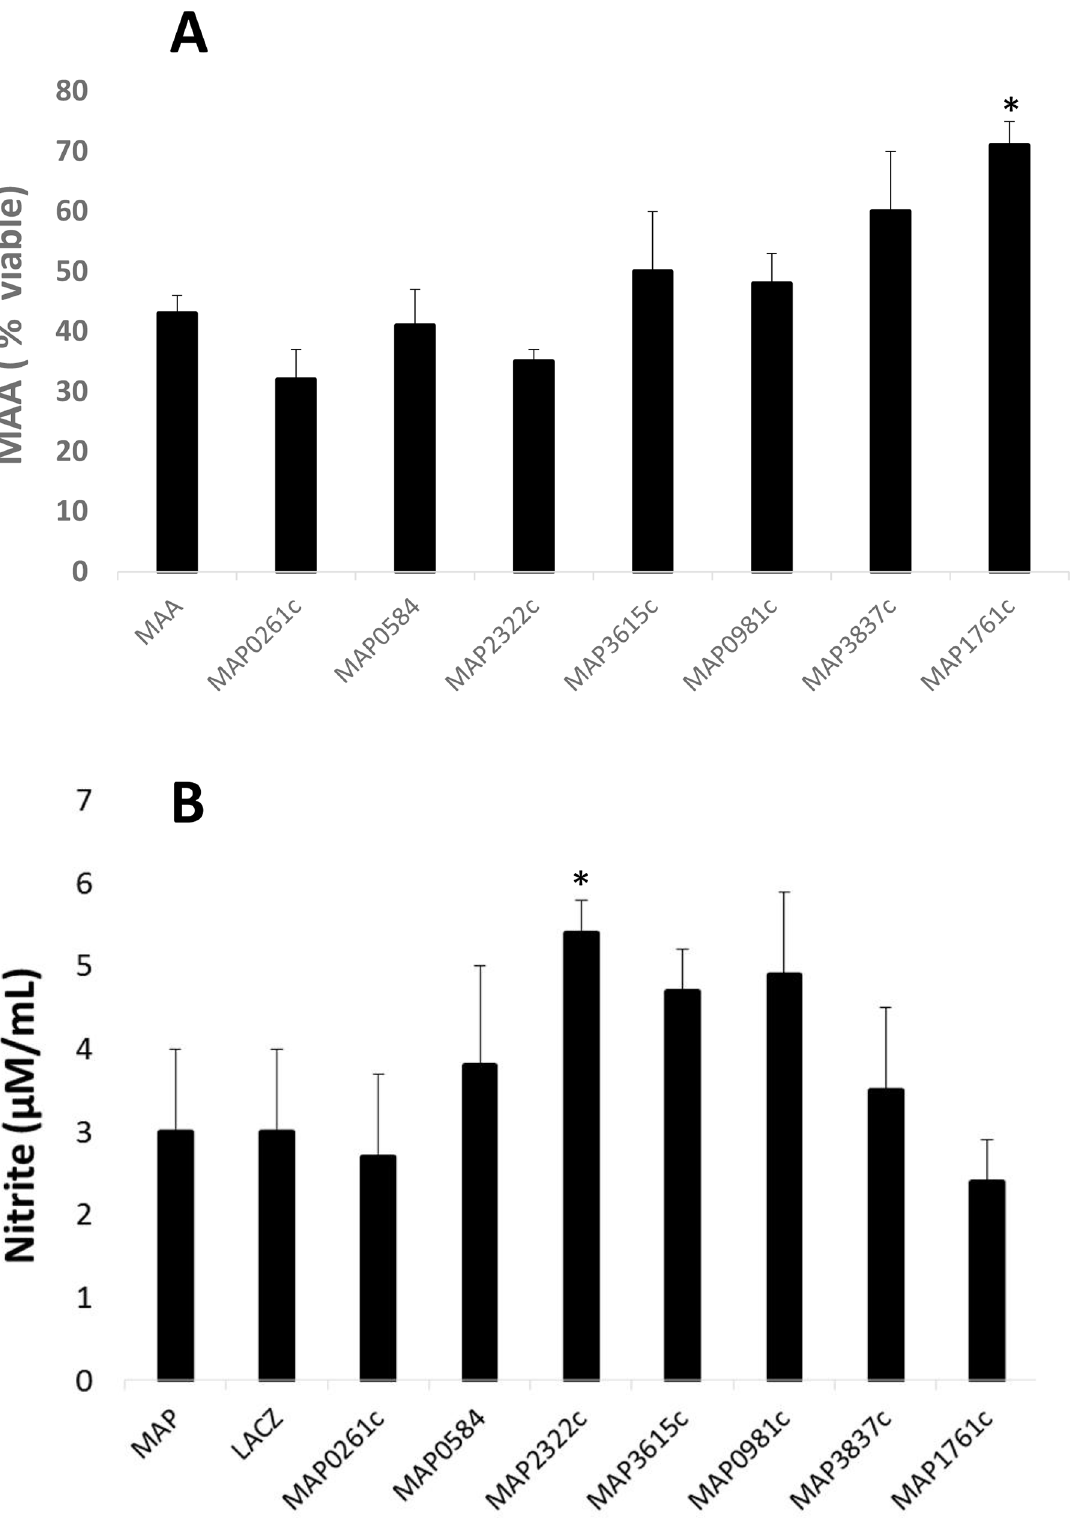
Fig 2. MAP1761c promotes survival of M . avium in bovine macrophages. Macrophages were incubated with or without recombinant proteins (5 μ g/ml) for 2 h and then infected with M . avium for 72 h. (A) Preincubation of macrophages with MAP1761c resulted in 71 ± 4% viability. The other lipoproteins